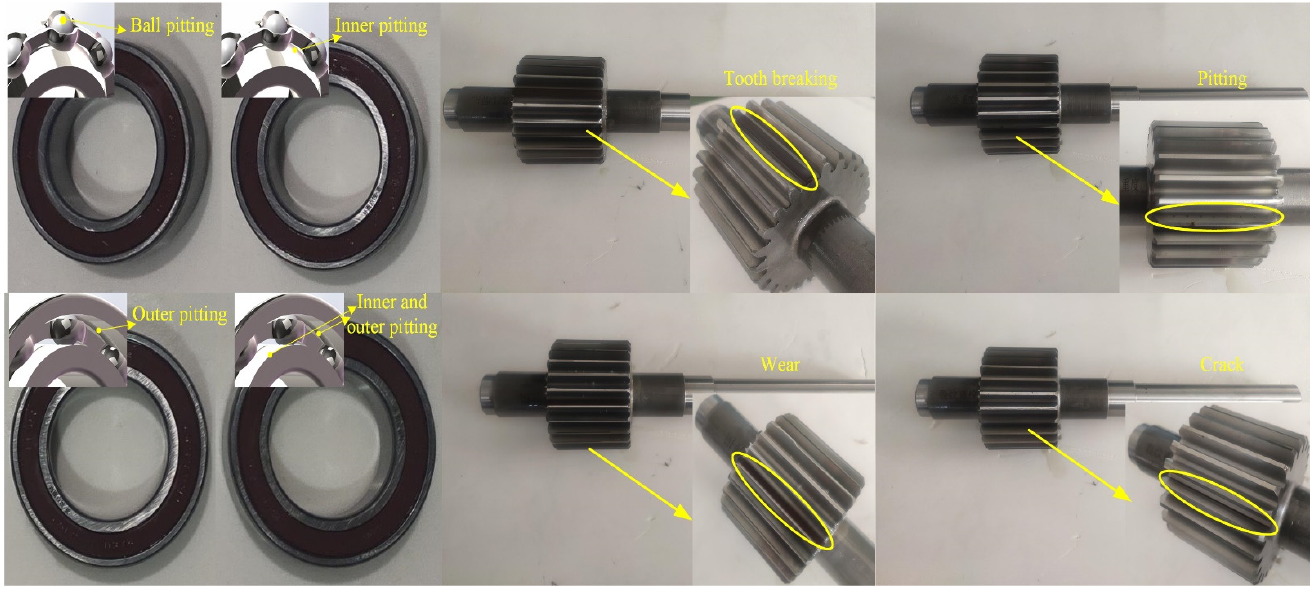
Figure 17. The components with various faults.